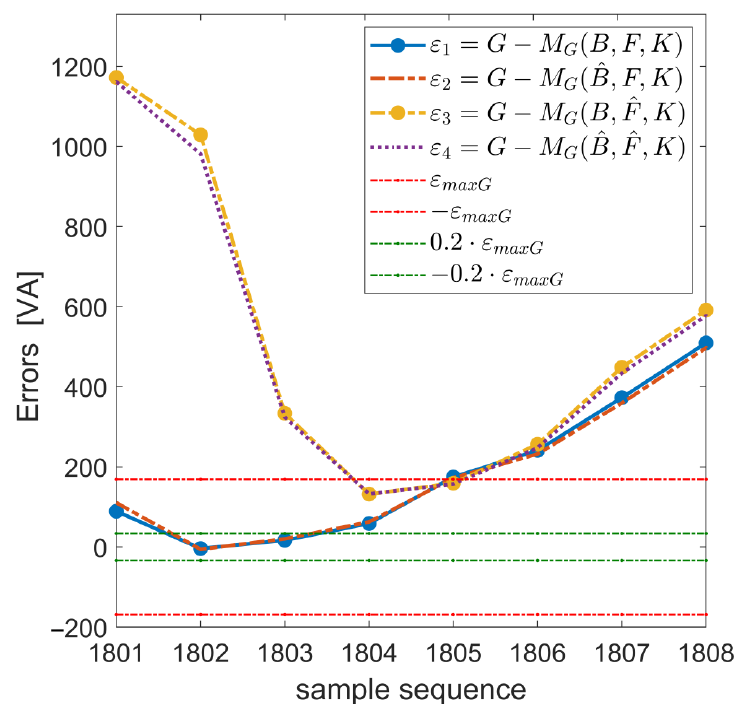
Figure 8. False alarm rejection thresholds. Table 5. Agent activation thresholds for one, two, and three years.